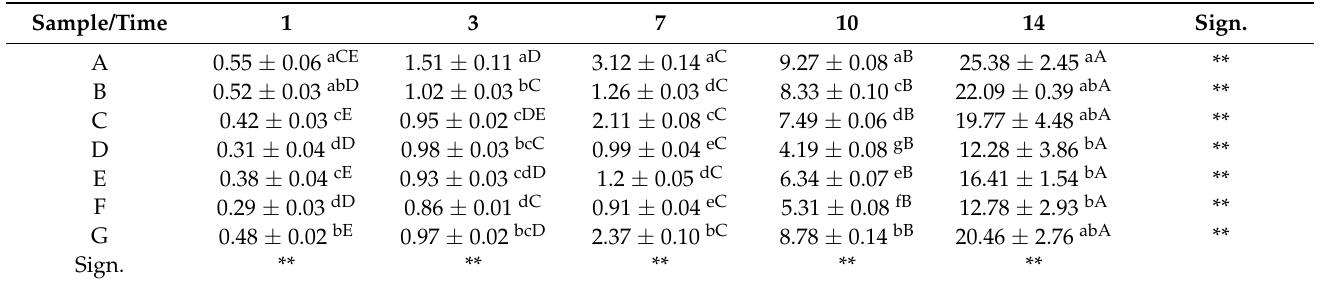
Table 4. Weight loss (%) values of the strawberries during storage